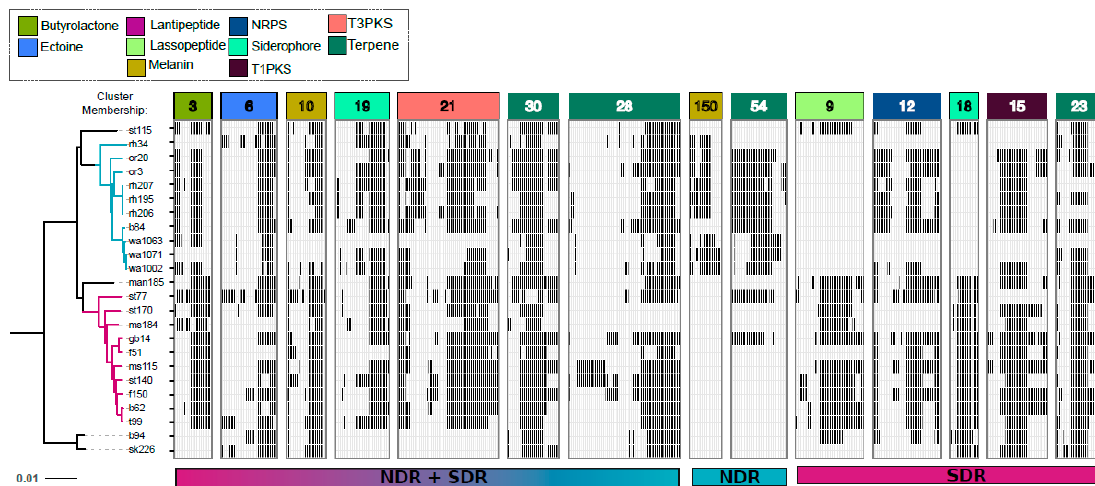
Figure 7. Gene content of core SMGCs vary within and between clades as a result of gene acquisition and deletion events. Panels depict the gene content (i.e., genetic architecture) of core SMGCs (i.e., conserved in ≥ 80% of genomes), the NDR-specific SMGC core, and the SDR-specific SMGC core. Black bars within the panels represent orthologous genes. The tree reflects phylogenetic relationships between Streptomyces sister-taxa genomes and was constructed from multiple whole genome alignments (see Figure 1). Scale bar represents nucleotide substitutions per site. Panel colors correspond to SMGC class (see legend). Panels are labeled with the SMGC cluster membership (see Table S3) defined using our annotation-independent approach (see Materials and Methods).